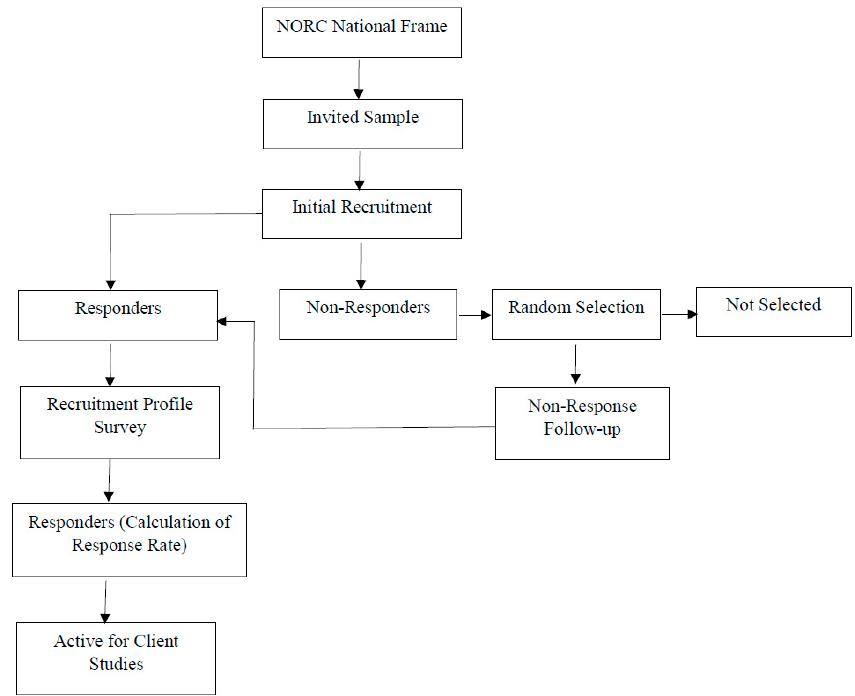
Figure 1. AmeriSpeak Panel Recruitment Methodology-Participants Selection Flowchart: The NORC national frame is an area probability sample of 3 million households based on the USA Postal Service Sequence File (covers approximately 97% of USA households) [16]. Abbreviations: NORC: National Opinion Research Center.